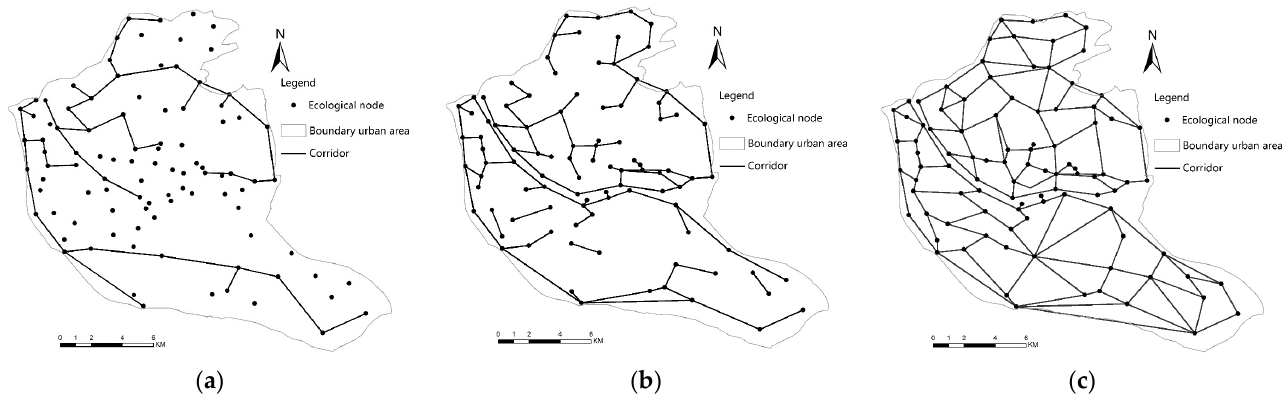
Figure 10. Fuzhou green space ecological network plan sketch: ( a ) network I; ( b ) network II; ( c ) network III.